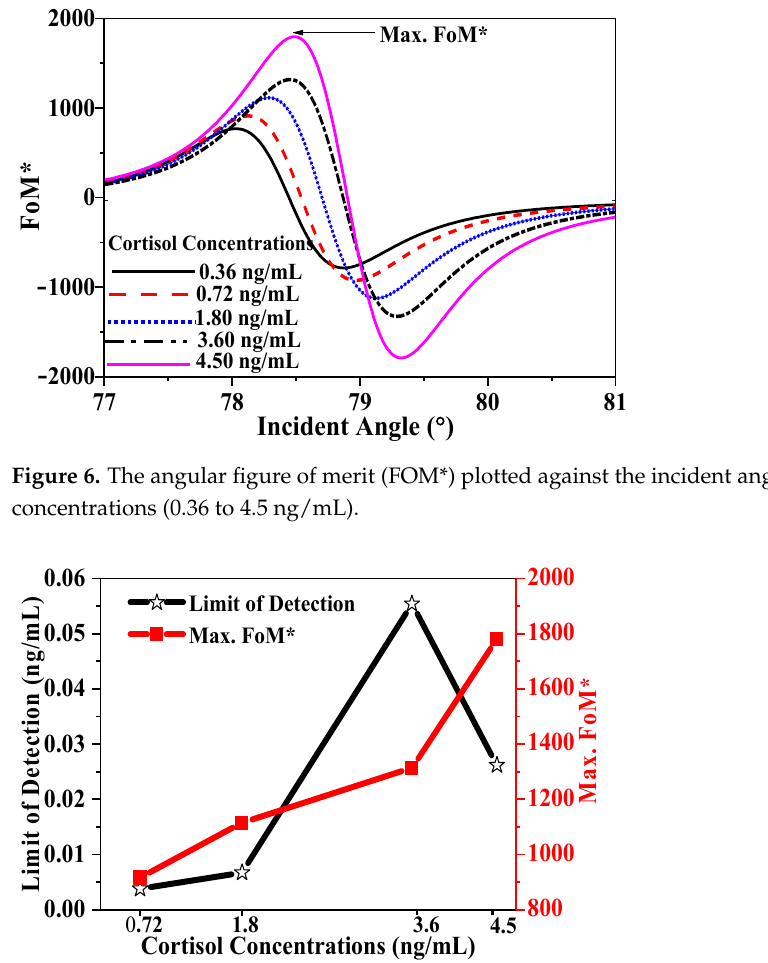
Figure 7. LOD and maximum FOM* for different cortisol concentrations (0.72 to 4.5 ng/mL).